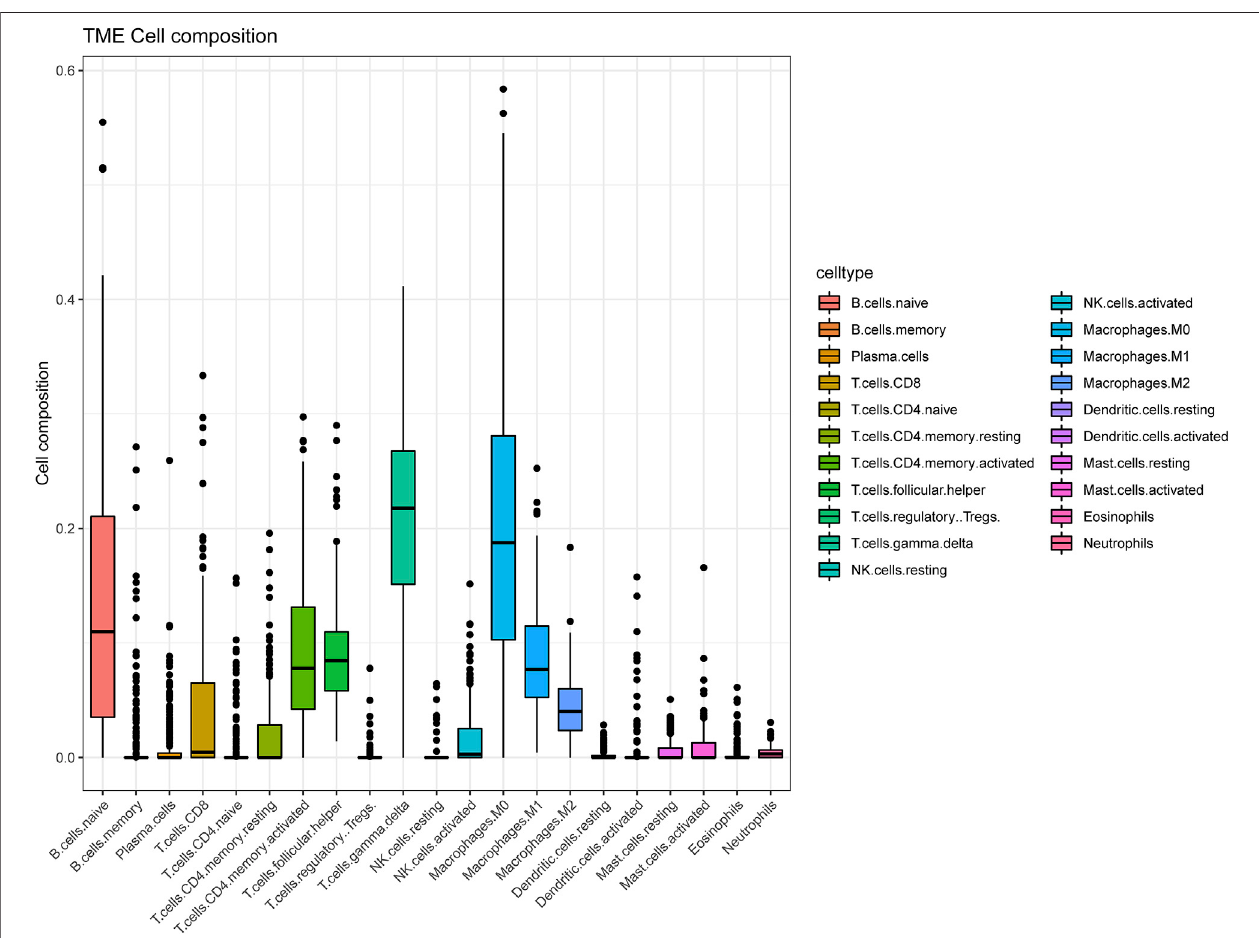
FIGURE 2 | The landscape of immune cells in fi ltration of DLBCL patients in GSE87371.